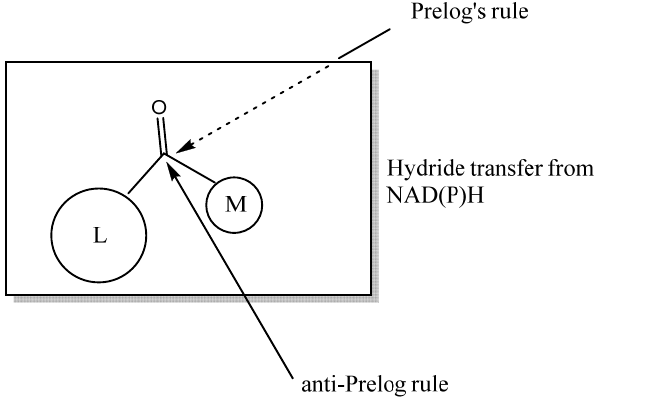
Figure 1. Hydride transfer according Prelog’s and anti-Prelog rules (L, large group; M, medium